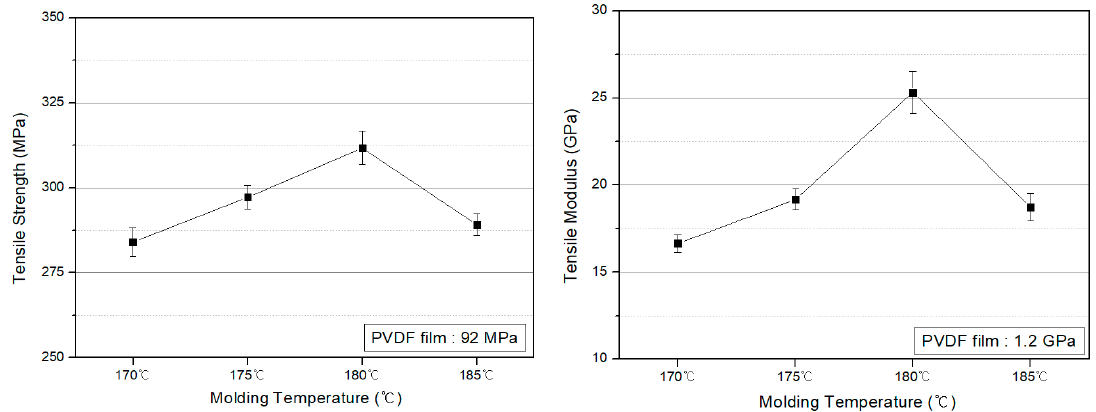
Figure 6. Tensile strength and tensile modulus of the PVDF/PAR composites prepared at different molding temperatures.